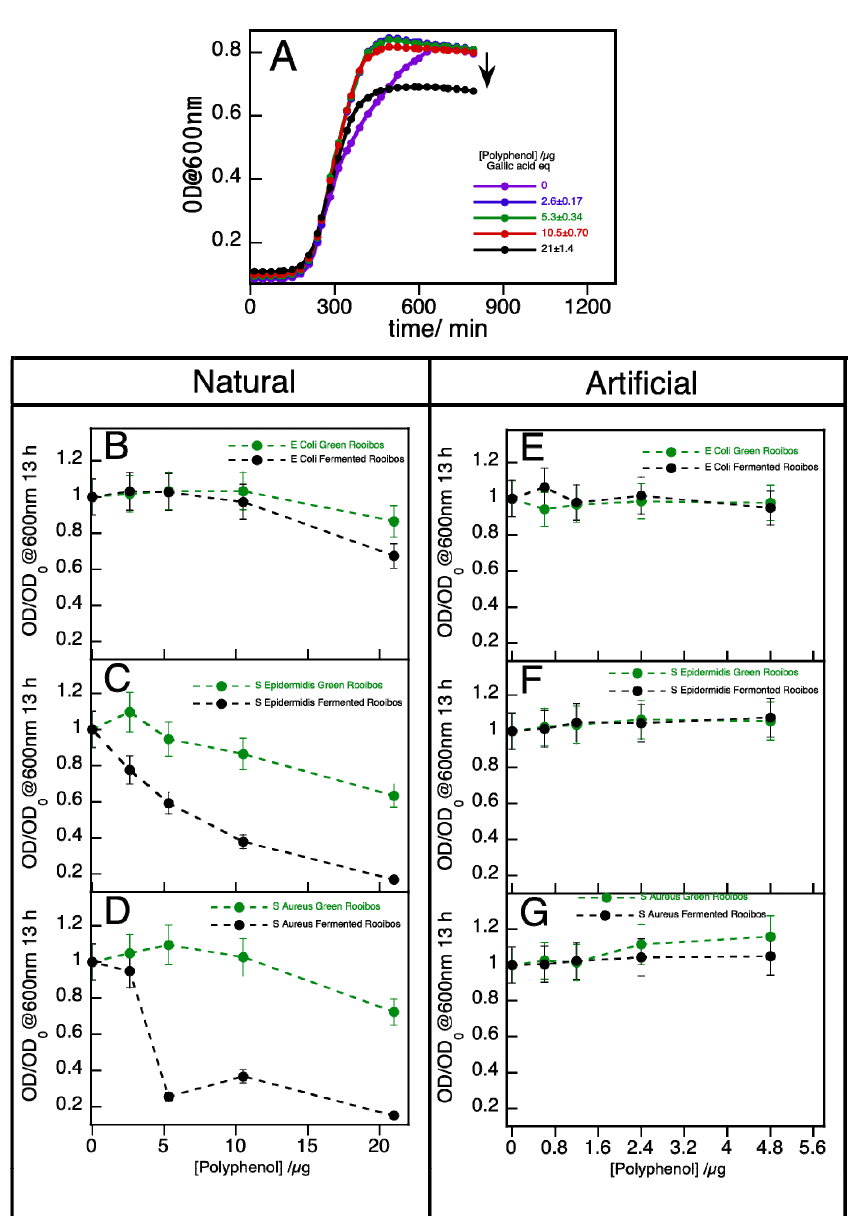
Figure 3. Antimicrobial efficacy of natural and artificial green and fermented infusions. Changes in optical density (OD ) of exposed E. coli, incubated at 37 °C in the presence of 600 different dilutions (indicated as µg GAE) of natural green rooibos infusion ( A ). Variations in the OD measured at 600 nm after 13 h (expressed as OD/OD ), measured for E. coli max 0 ( B and E ), S. aureus ( C and F ) and S. epidermidis ( D and G ) at variable infusion concentrations of natural ( B , C and D ) or artificial ( E , F and G ) rooibos infusions. Polyphenol concentrations (for natural infusions) were estimated from the Folin-Ciocalteu polyphenol content reported in Table 3. The standard error in all cases was lower than 10% and 10% error bars have been included to facilitate data